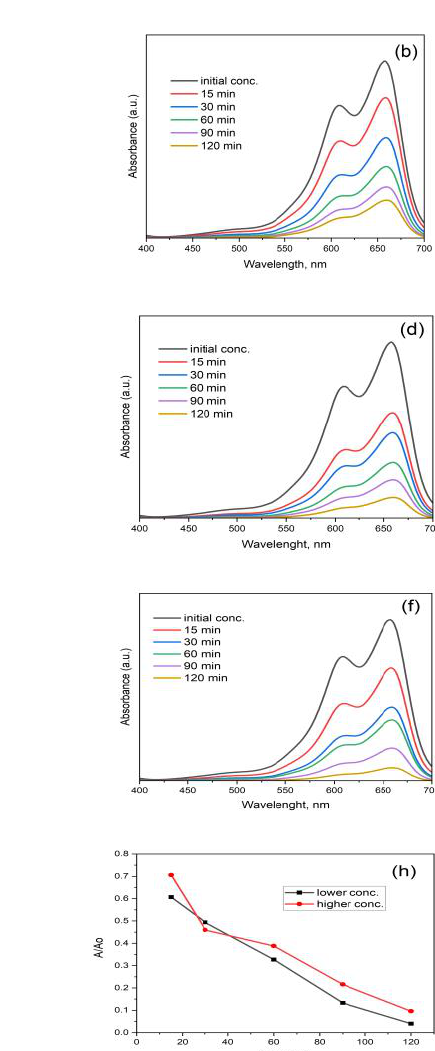
Figure 7. Pseudo-first order kinetics of MB degradation over different catalyst dosages of Ru- ZnO/SBA-15: ( a ) 10 mg; ( b ) 30 mg; and ( c ) 50 mg.